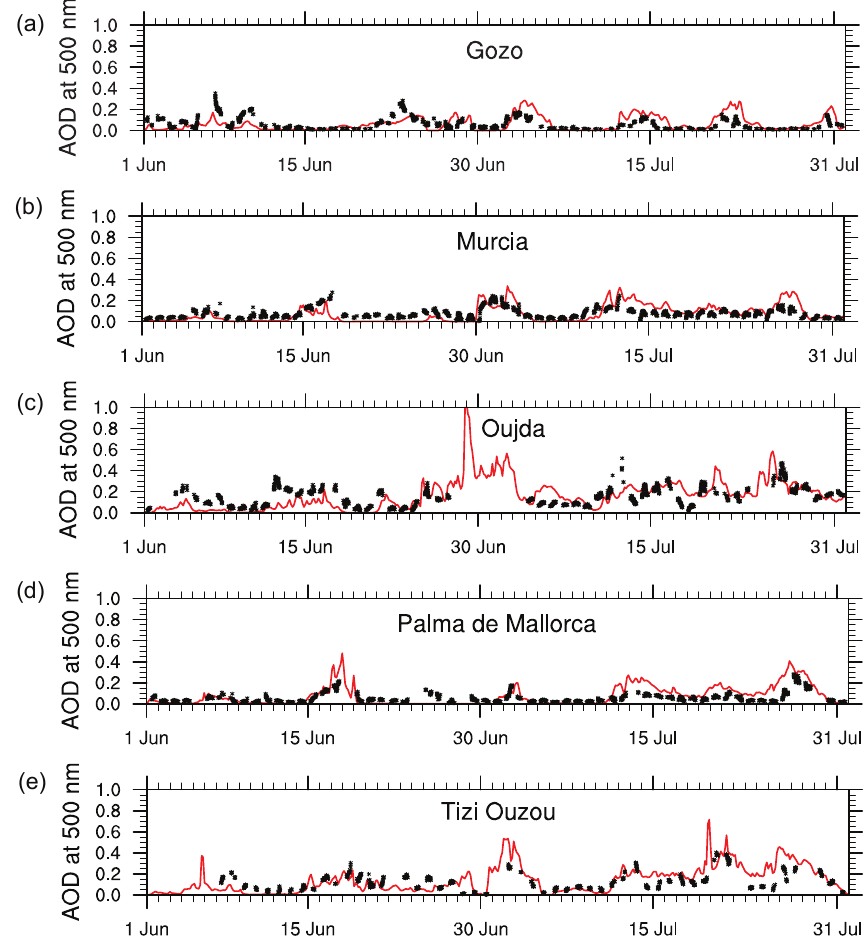
Figure 2. Temporal evolution of dust AOD at five different stations (see Fig. 1) located along frequent dust transport routes. Dust AODs calculated from 3-hourly COSMO-MUSCAT output for June and July 2013 are represented by the red line, AERONET level 2.0 coarse- mode AOD retrievals from sun-photometer measurements are shown in black. COSMO-MUSCAT dust AODs are calculated for the grid cell corresponding to the AERONET measurement